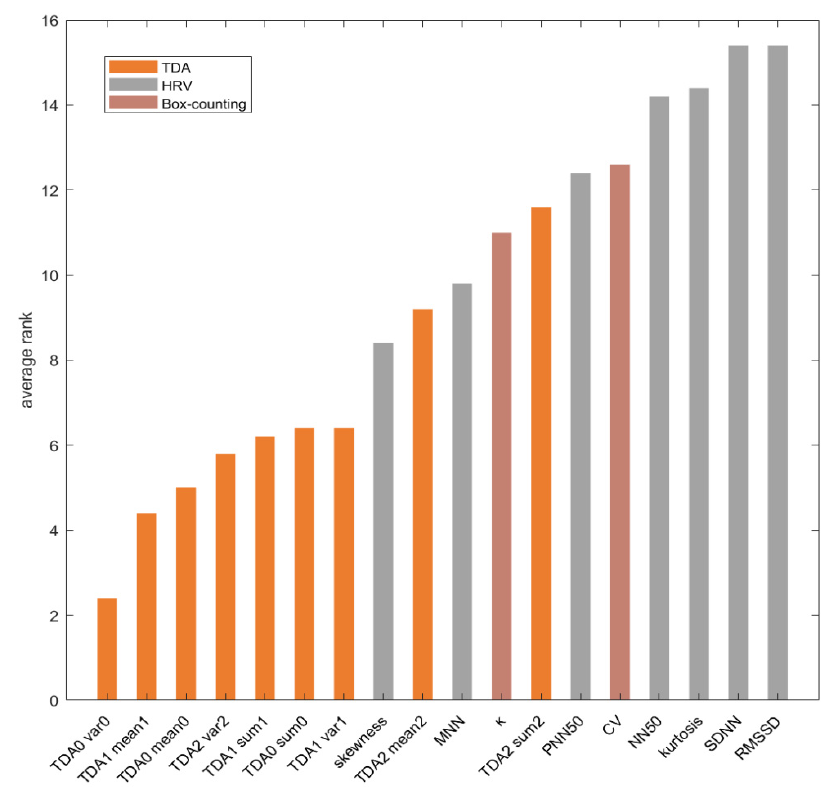
Figure 7. Average rank of each